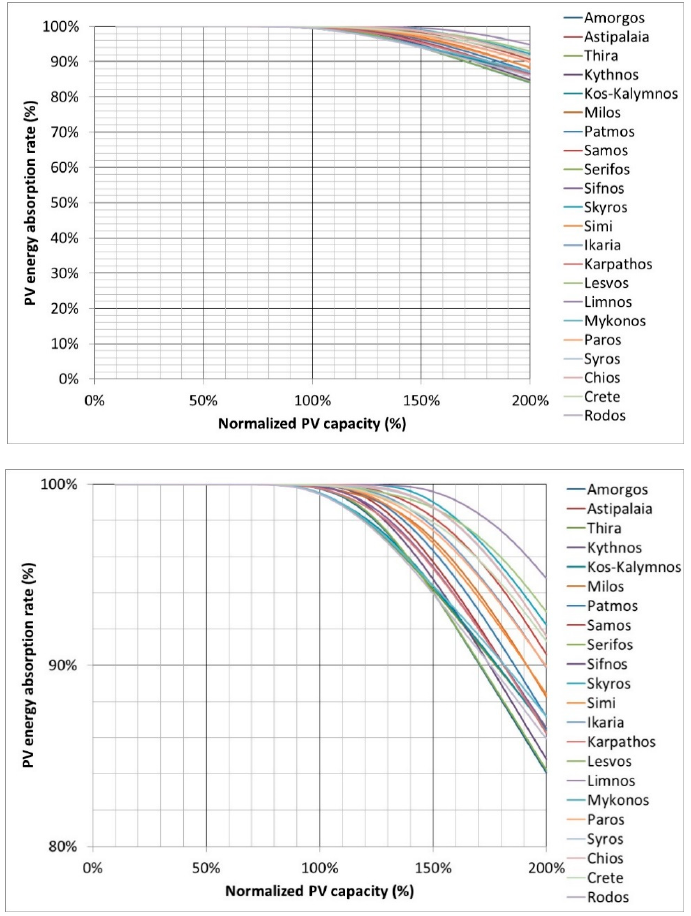
Figure 14. PV energy absorption rate for normalized PV capacity of 0% up to 200% (regardless of the wind capacity).